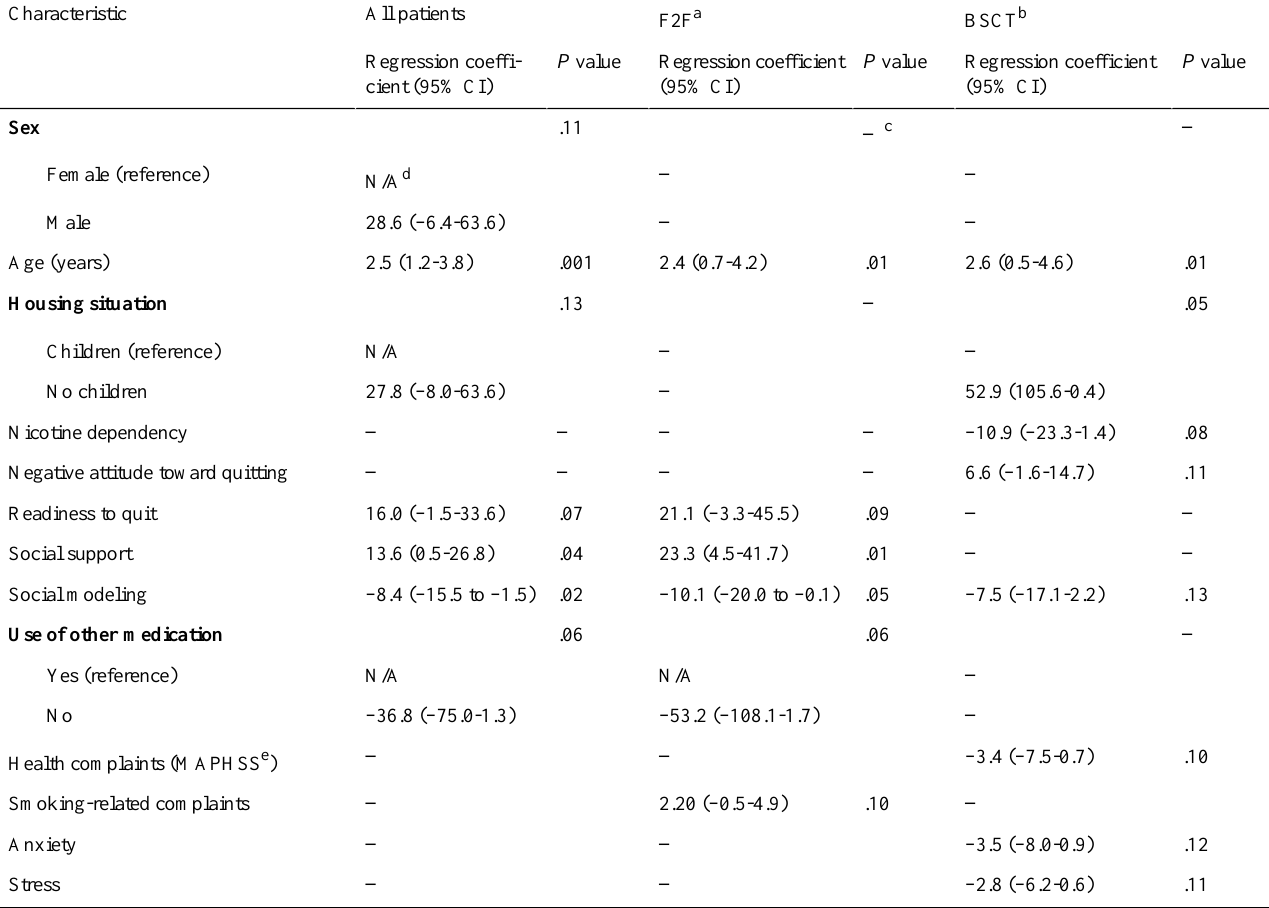
Table 4. Univariate predictors for adherence in all patients and in each treatment